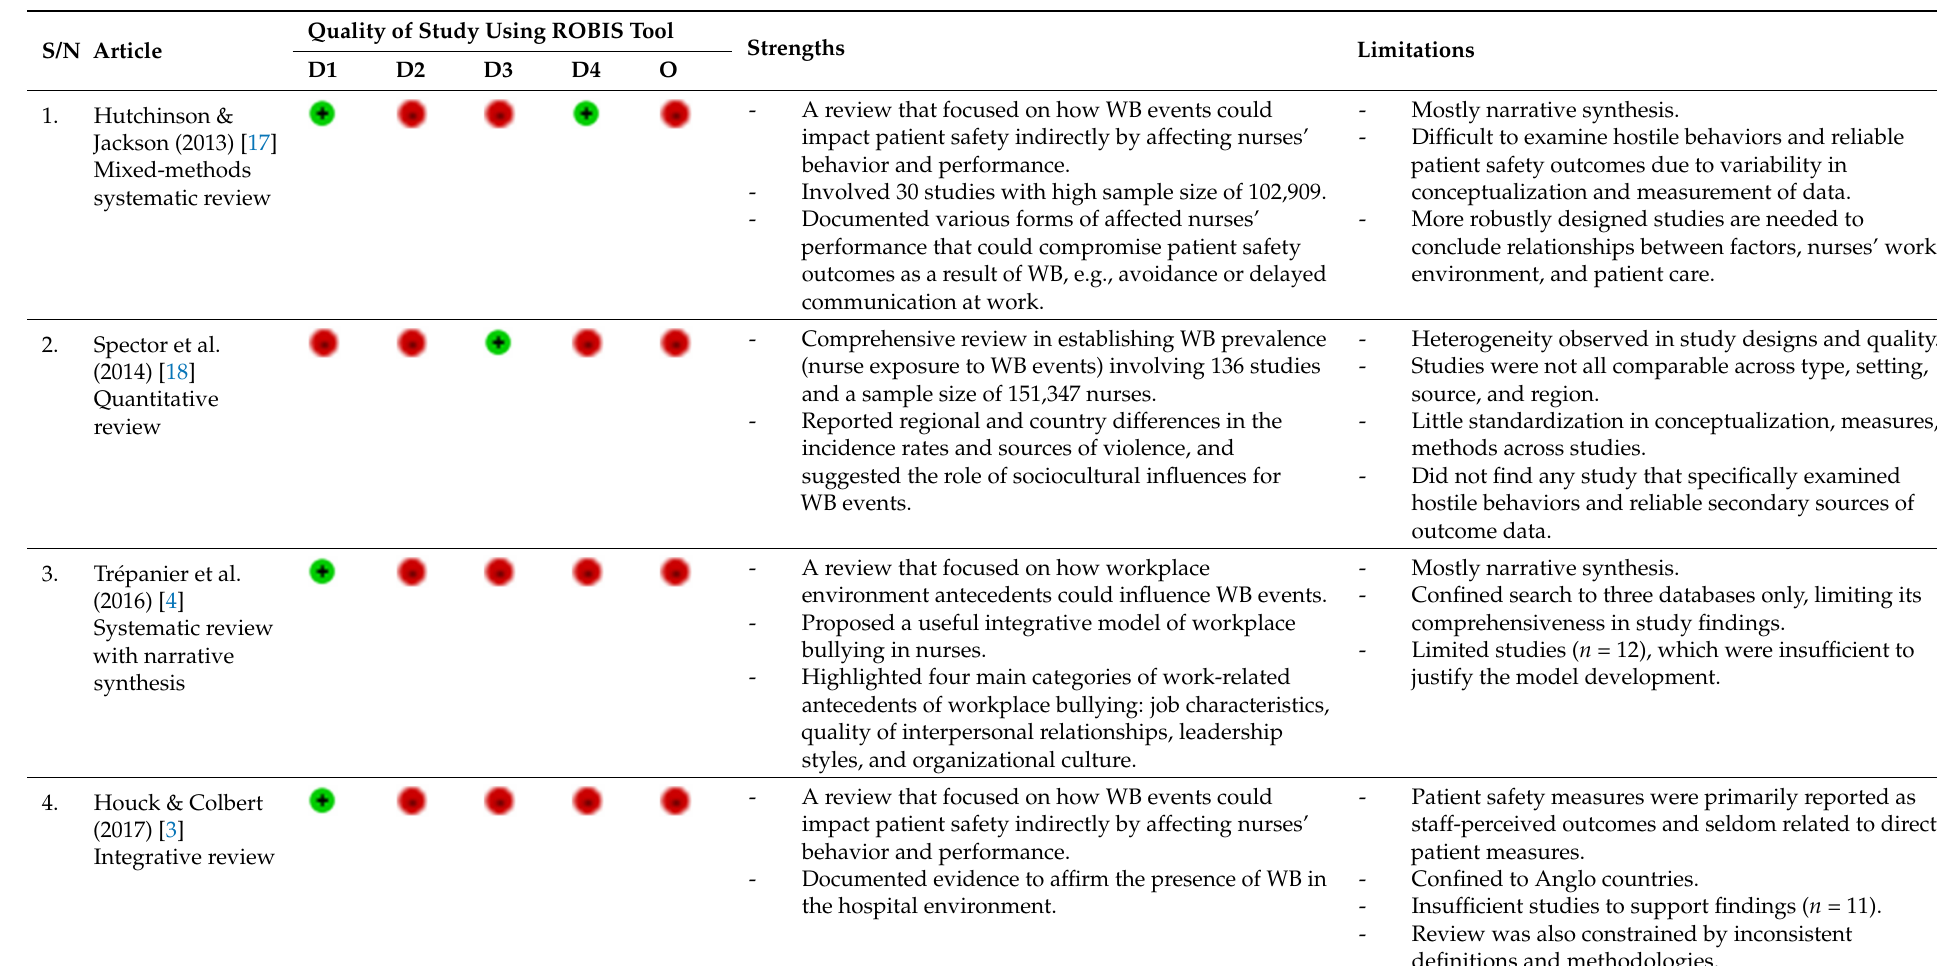
Table 2. Quality appraisal of included systematic